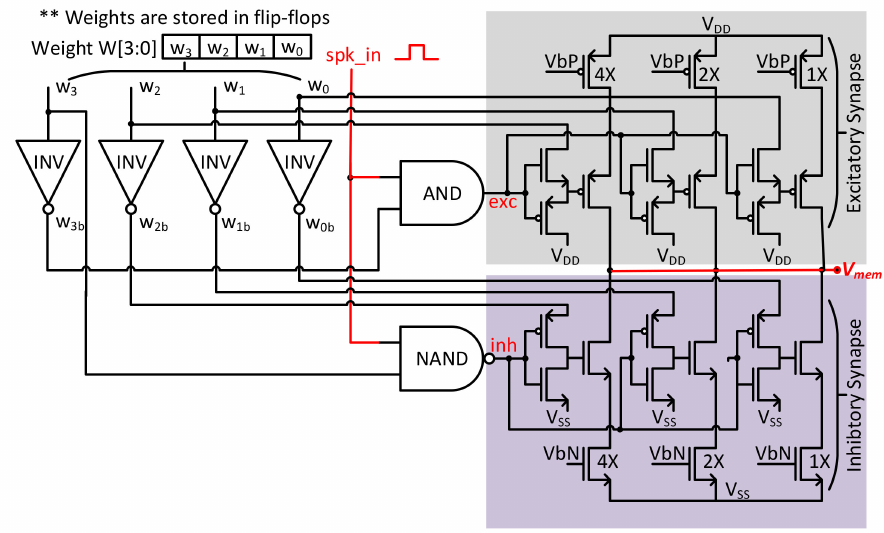
Figure 4. The circuit schematic for the BECI-based synapse with three branches and digital gates.